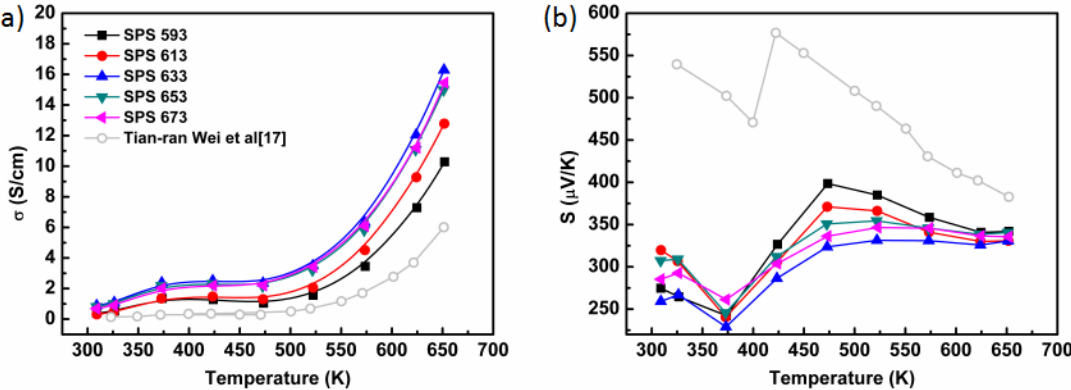
Figure 4. Temperature dependence of thermoelectric properties for all the samples with different SPS temperature and reference [17]: ( a ) electrical conductivity; and ( b ) the Seebeck coefficient.